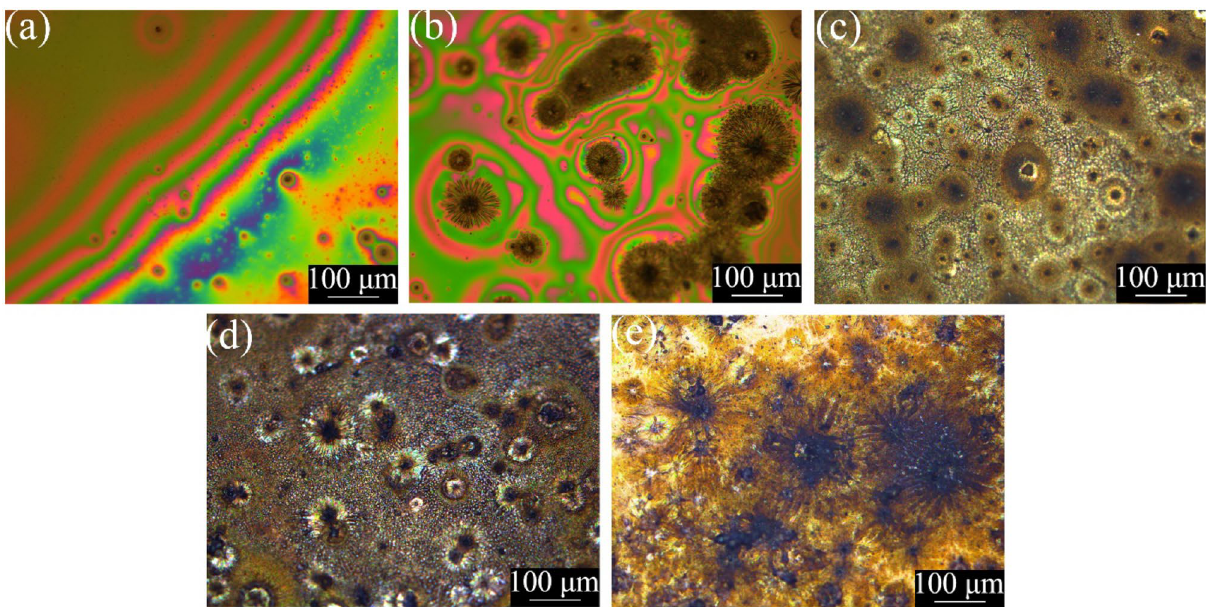
Figure 2. Optical images displaying the features of the films of m-cresol created by plasma exposure durations of ( a ) 0.5 min, ( b ) 1 min, ( c ) 2 min, ( d ) 3 min, and ( e ) 4 min on a Si